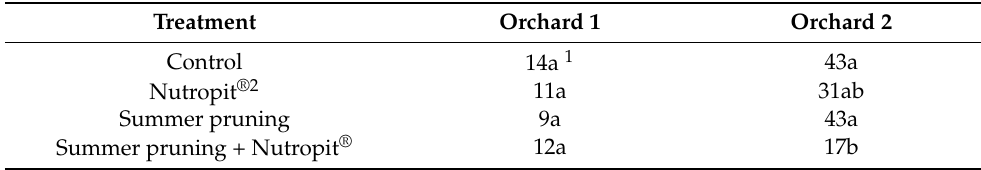
Table 3. Effect of sustainable techniques on senescent breakdown (%) in apple cv. ‘Reinette du Canada’ after 180 days of